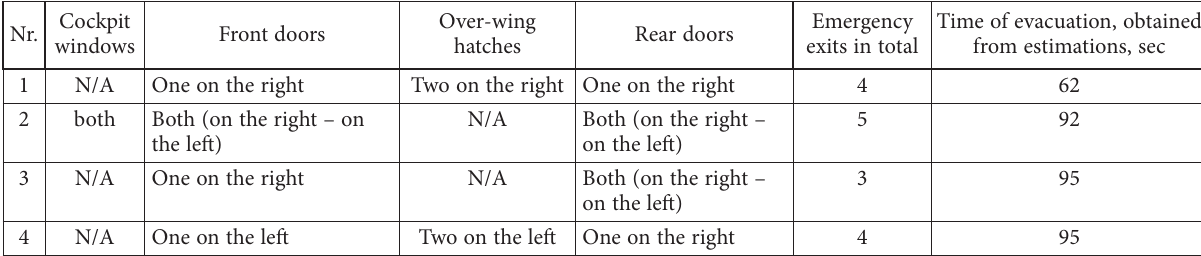
Figure 4. Design Model of the aircraft of SSJ-100 type Table 1. Number of properly functioning emergency